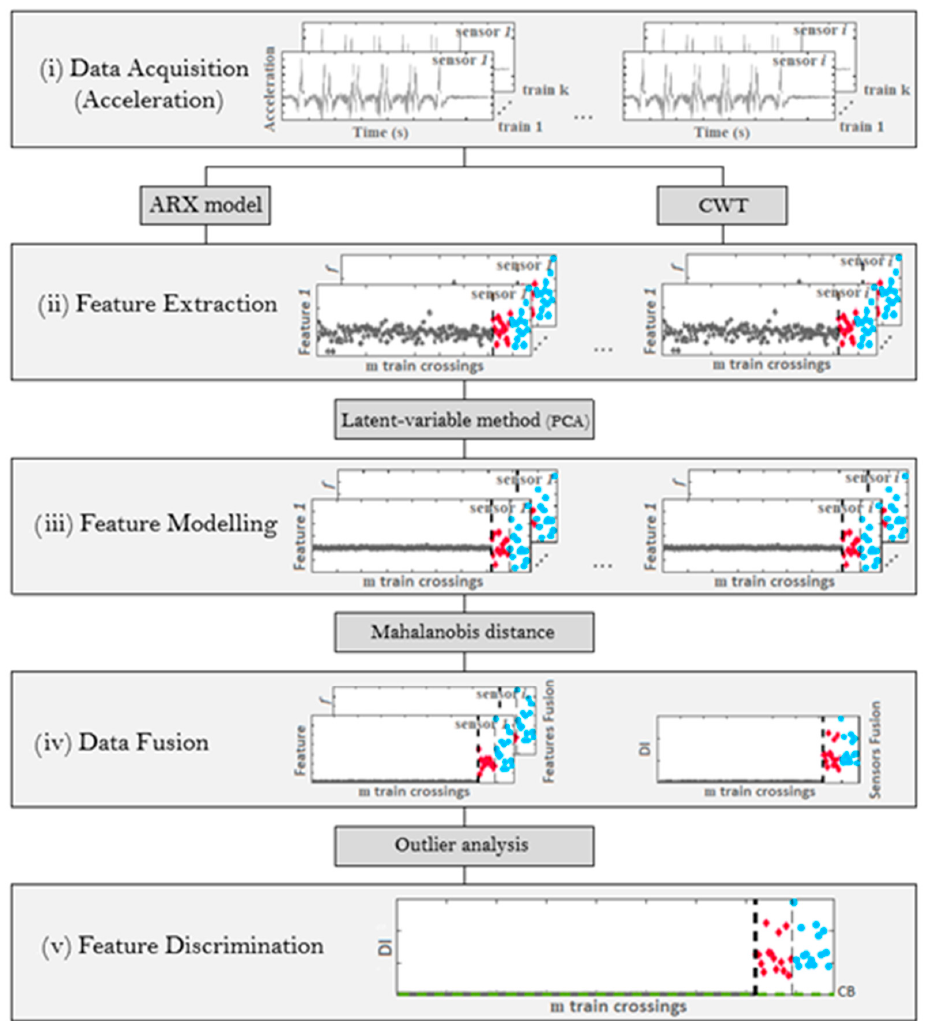
Figure 1. Flowchart of the damage detection methodology.